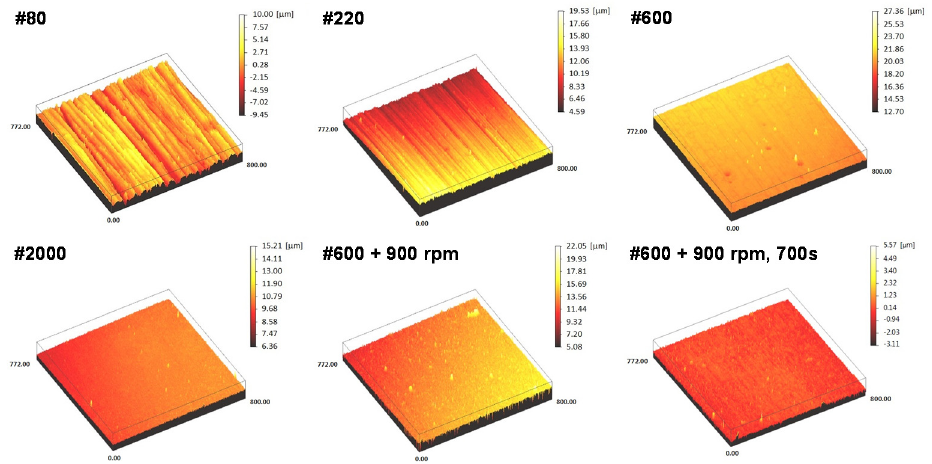
Figure 9. 3D surface roughness profile of magnetite films on carbon steel substrates with different roughnesses and agitation speeds.